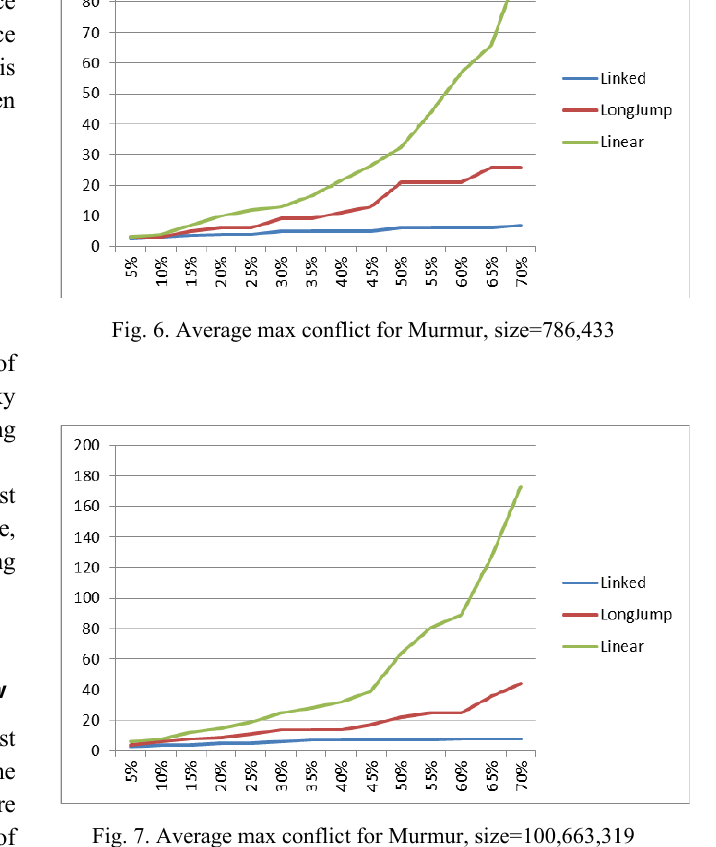
Fig. 7. Average max conflict for Murmur,